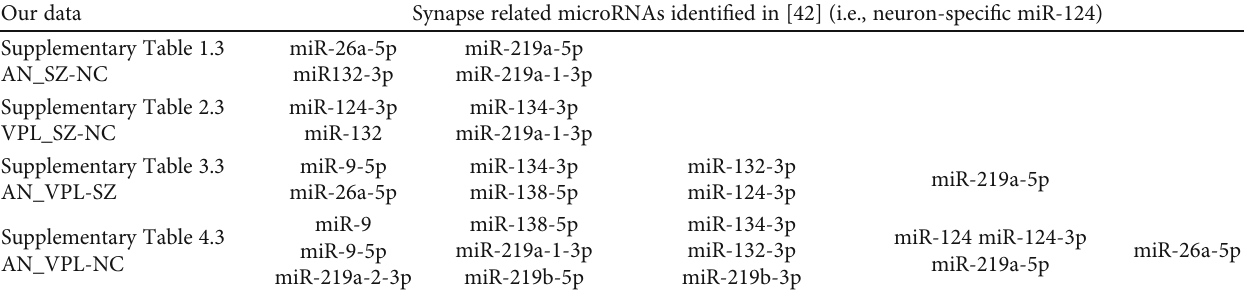
Table 4: Synapse-relevant microRNAs (Gerhard [42]) found in our study. Our data Supplementary Table